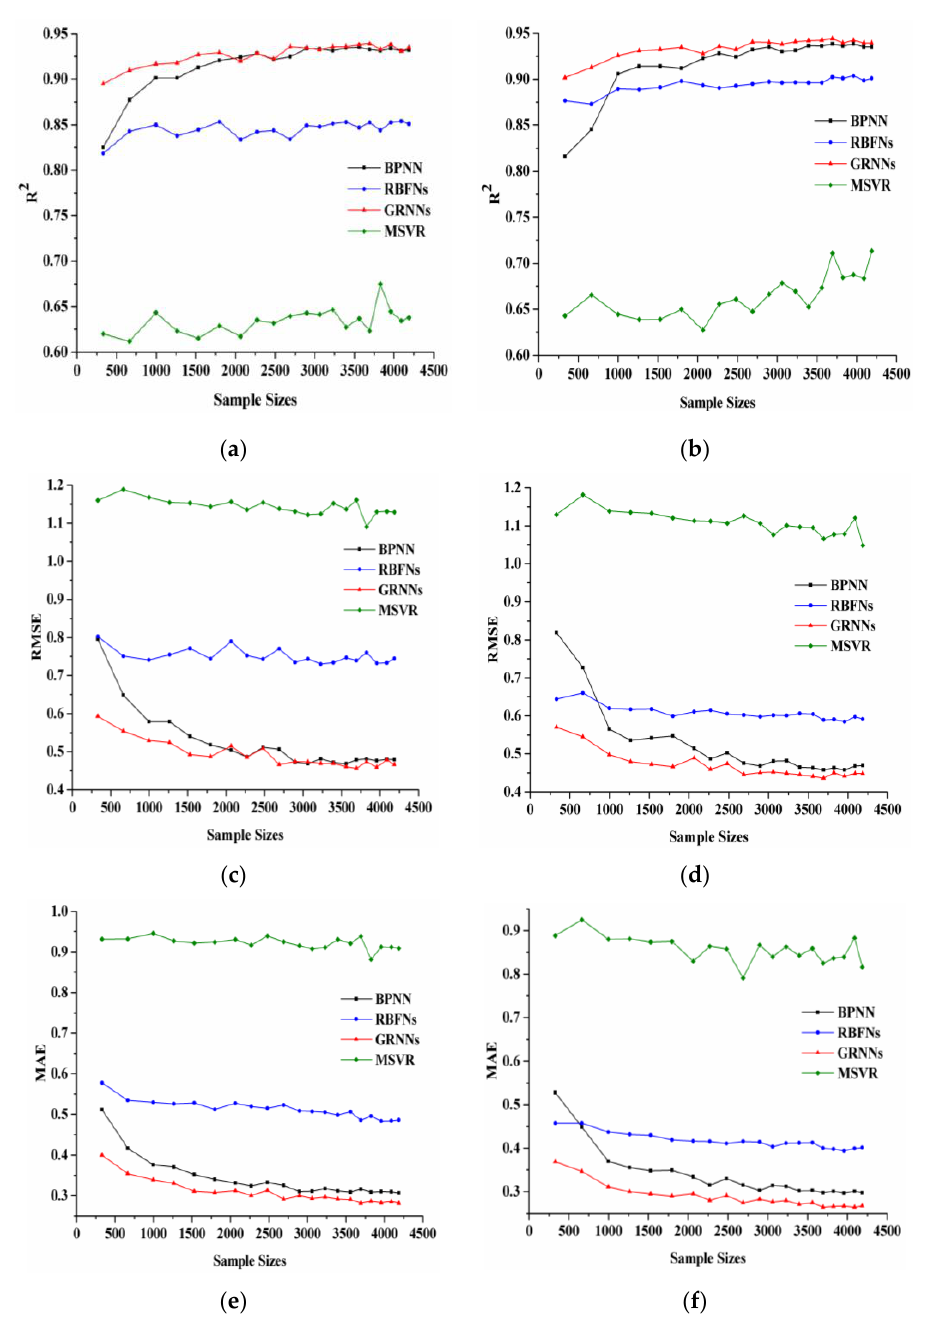
Figure 3. Sensitivity of the machine learning algorithms to sample size. Changes of R 2 with training sample sizes for (a) the LAI values derived from reflectance data in the red and NIR bands and (b) the LAI values derived from reflectance data in the red, NIR, and SWIR bands; changes of RMSE with training sample sizes for (c) the LAI values derived from reflectance data in the red and NIR bands and (d) the LAI values derived from reflectance data in the red, NIR, and SWIR bands; changes of MAE with training sample sizes for (e) the LAI values derived from reflectance data in the red and NIR bands and (f) the LAI values derived from reflectance data in the red, NIR, and SWIR bands.